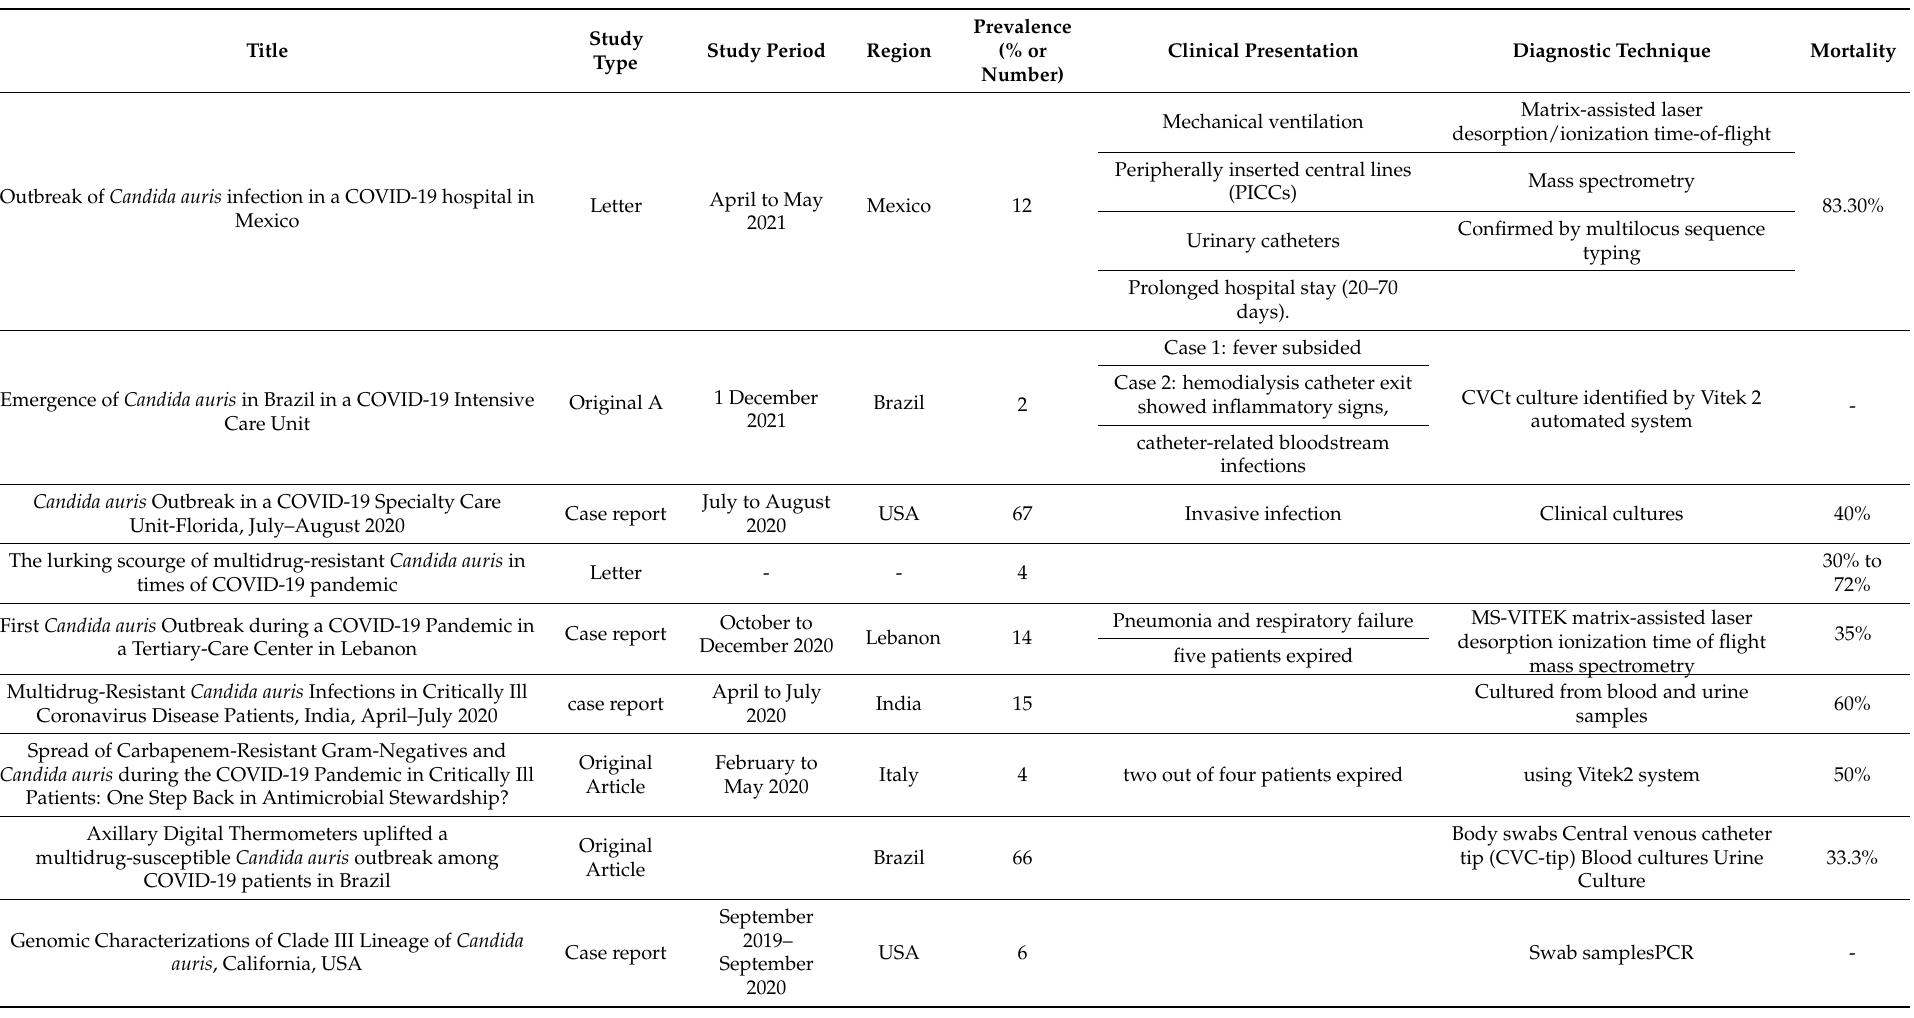
Table 1. Regions, clinical manifestations, diagnostic tools, and risk factors of C. auris in coronavirus